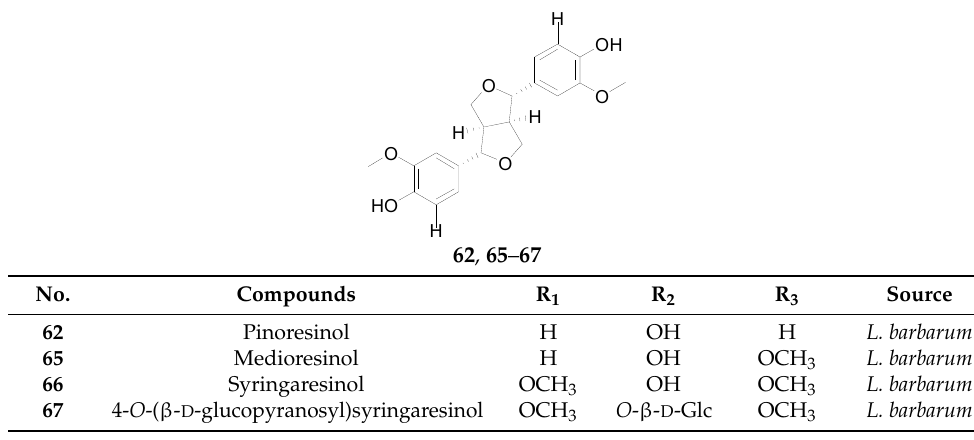
Table 6. Chemical structures of compounds 62 and 65 – 67 .